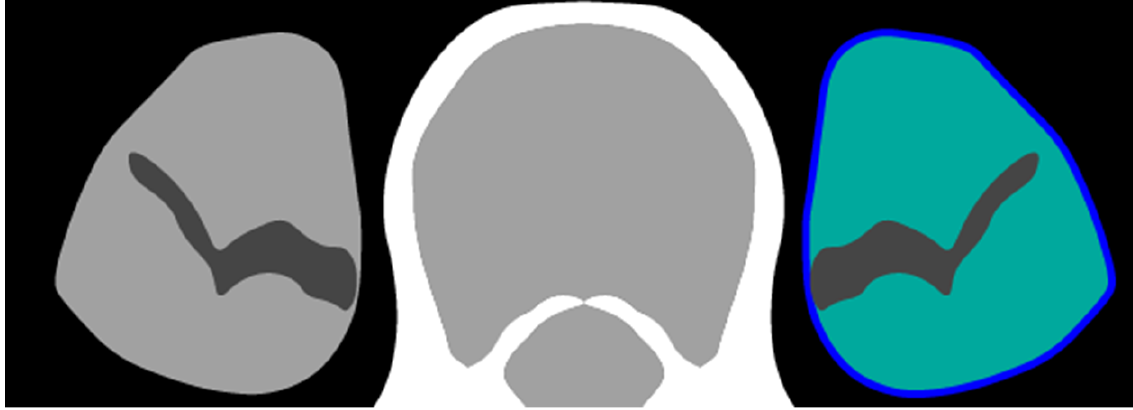
Figure 1. Schematic representation of measurements. The entire area of the psoas muscle on the L3 level was delineated (dark blue circumference). For psoas muscle index (PMI), only voxels with a radiodensity of − 30 Hounsfield units (HU) or higher were counted (light green area). For psoas muscle radiodensity (PMD), the average HU of all voxels in the delineated area was calculated, including fatty infiltration of the psoas